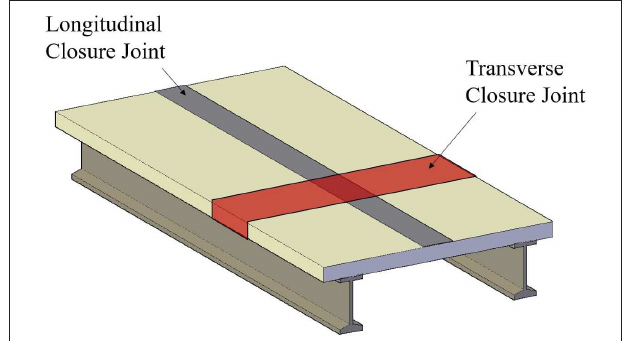
FIGURE 1 | Schematic view of closure